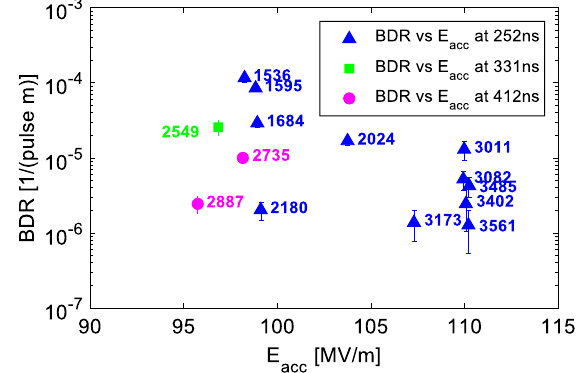
FIG. 8. Normalized BDR versus number of rf pulses.